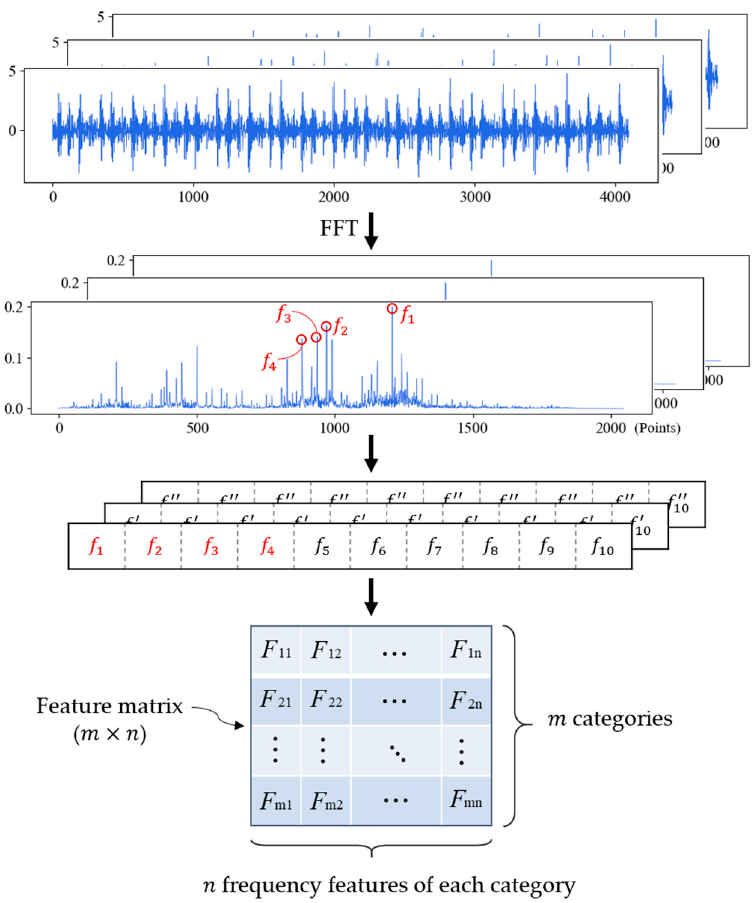
Figure 2. Training stage of FDFM algorithm.